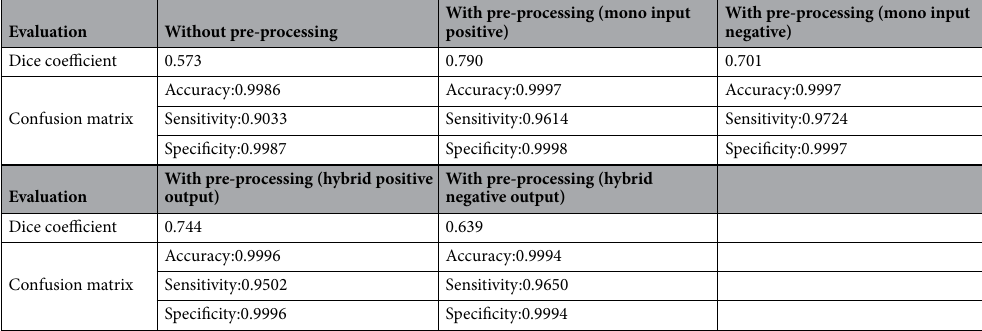
Table 2. The comparison of different method in lung nodule segmentation.